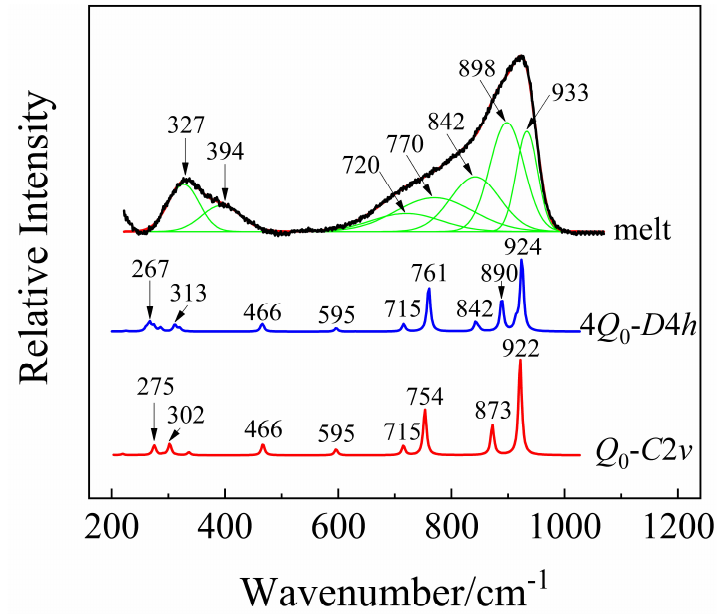
Figure 4. The deconvolution of Raman spectrum for the melt of KBi(MoO 4 ) 2 at 1023 K by Gaussian function, and the calculated Raman spectra by quantum chemistry ab initio calculation, where Q 0 and 4 Q 0 represent the structural unit and the corresponding multi-molecular clusters structure containing four structural